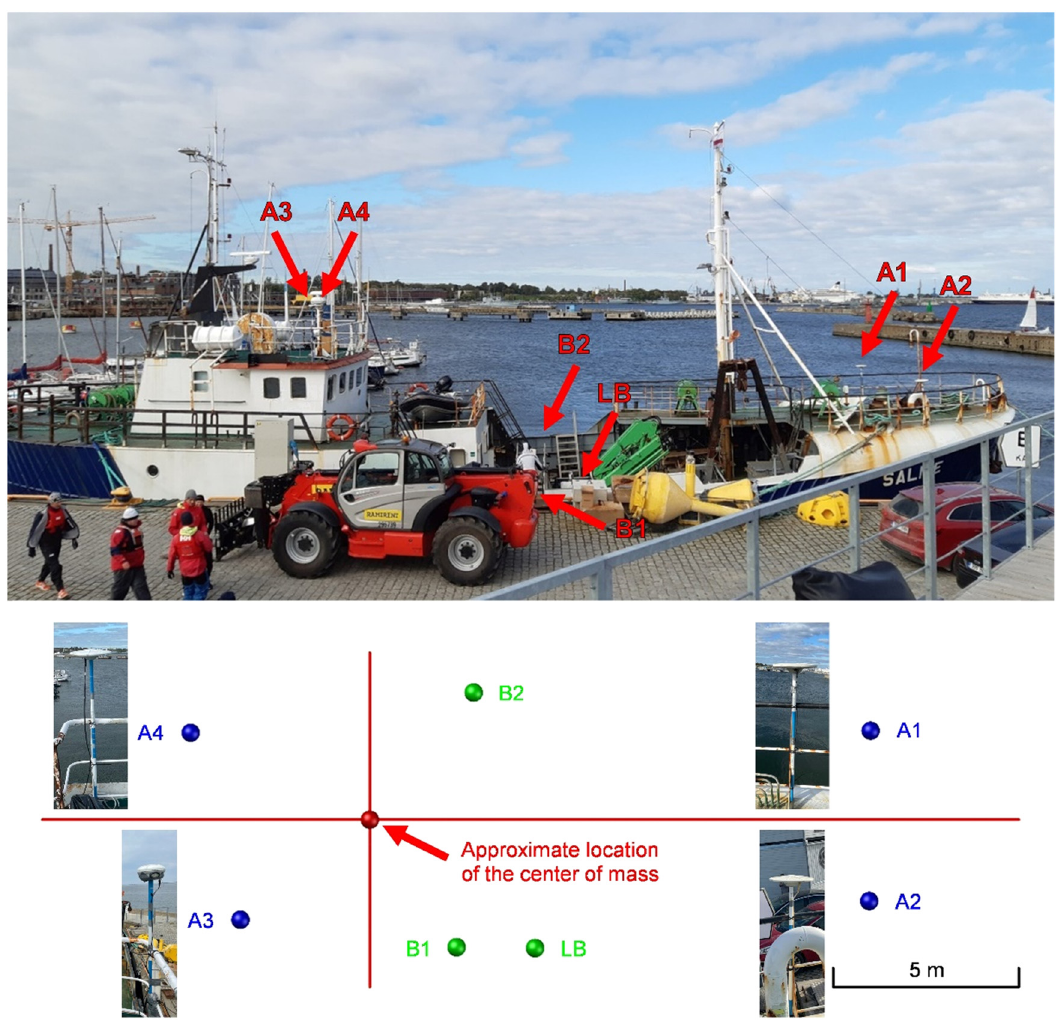
Figure 2: Research surveying vessel Salme and installed GNSS antennas ( A1, A2, A3, and A4 ) on the board. Water measurements were conducted relative to the benchmarks on the vessel ’ s railing ( points B1, B2, and LB; note that B1 is behind the loader ) . The red lines in the scheme denote the vessel ’ s principal axes.